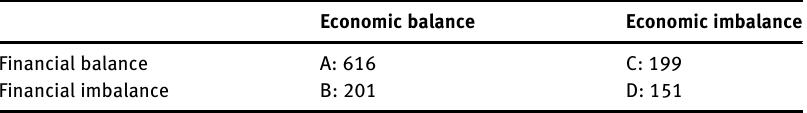
Table  : Results of matrix for fi nancial and economic health. Year  .